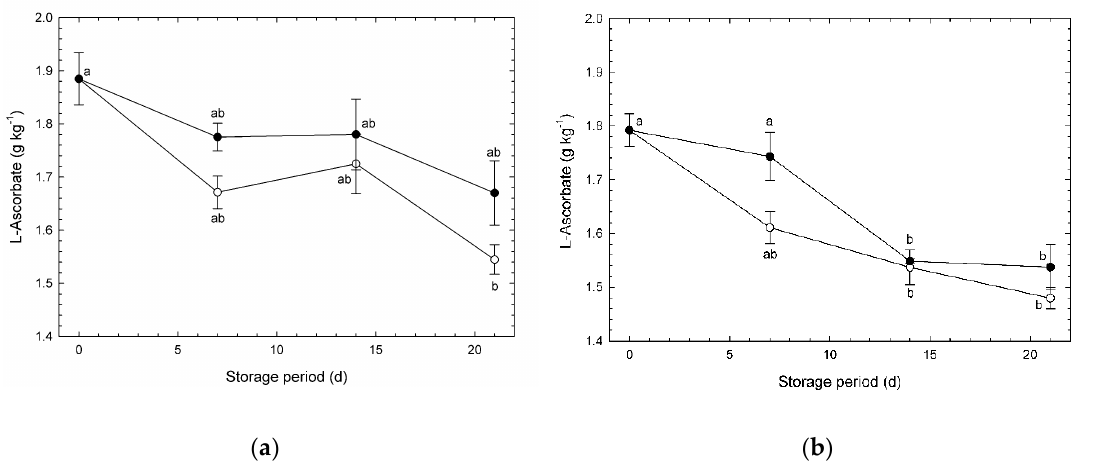
Figure 4. L-ascorbate concentrations in broccoli heads during storage at 1 °C. ( a ) Experiment #1: , normoxia; , O 2 /CO 2 = 2.5%/6.0% (+ N 2 to 100%). ( b ) Experiment #2: , normoxia; , O 2 /CO 2 = 2.5%/0.0% (+ N 2 to 100%). Values are means ± SE of three biological replicates. Significant differences ( p < 0.05) are denoted by different letters.